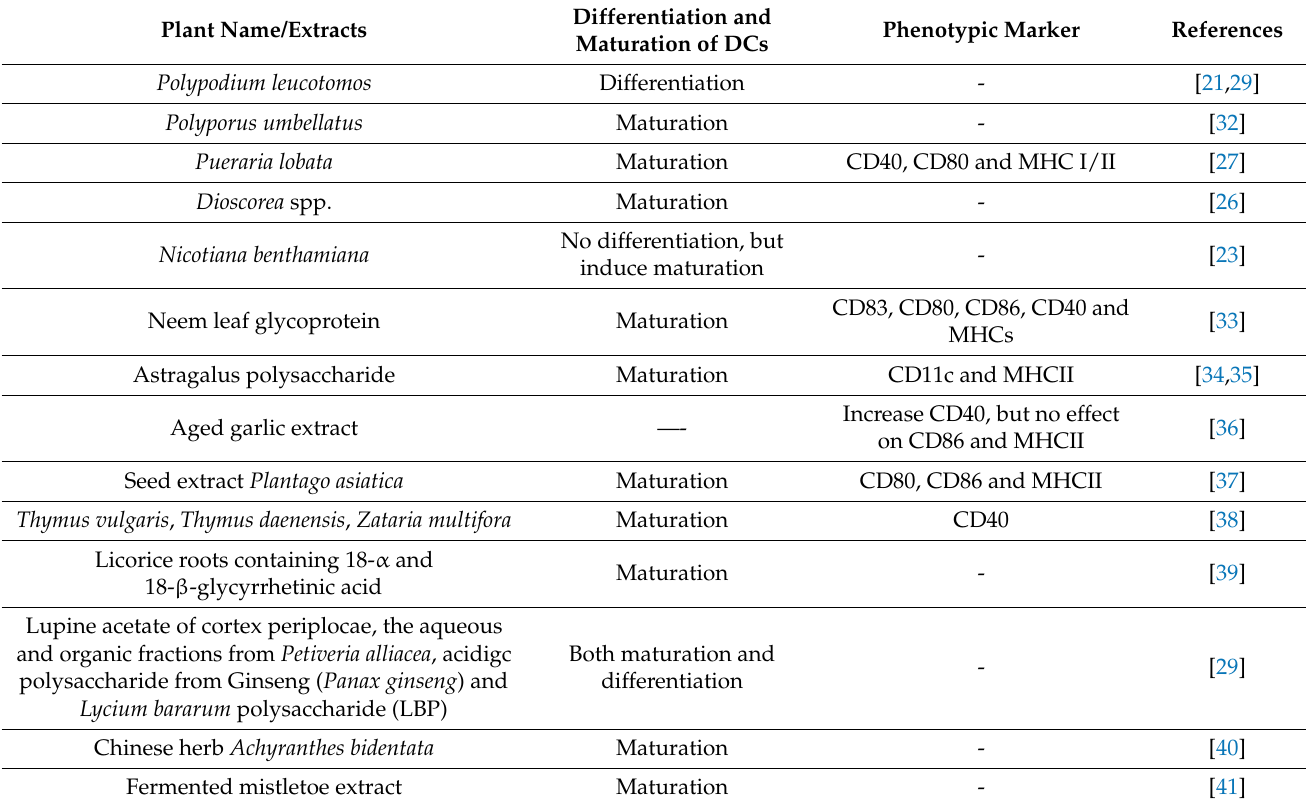
Table 1. Plant extracts on dendritic cells (DCs) differentiation and